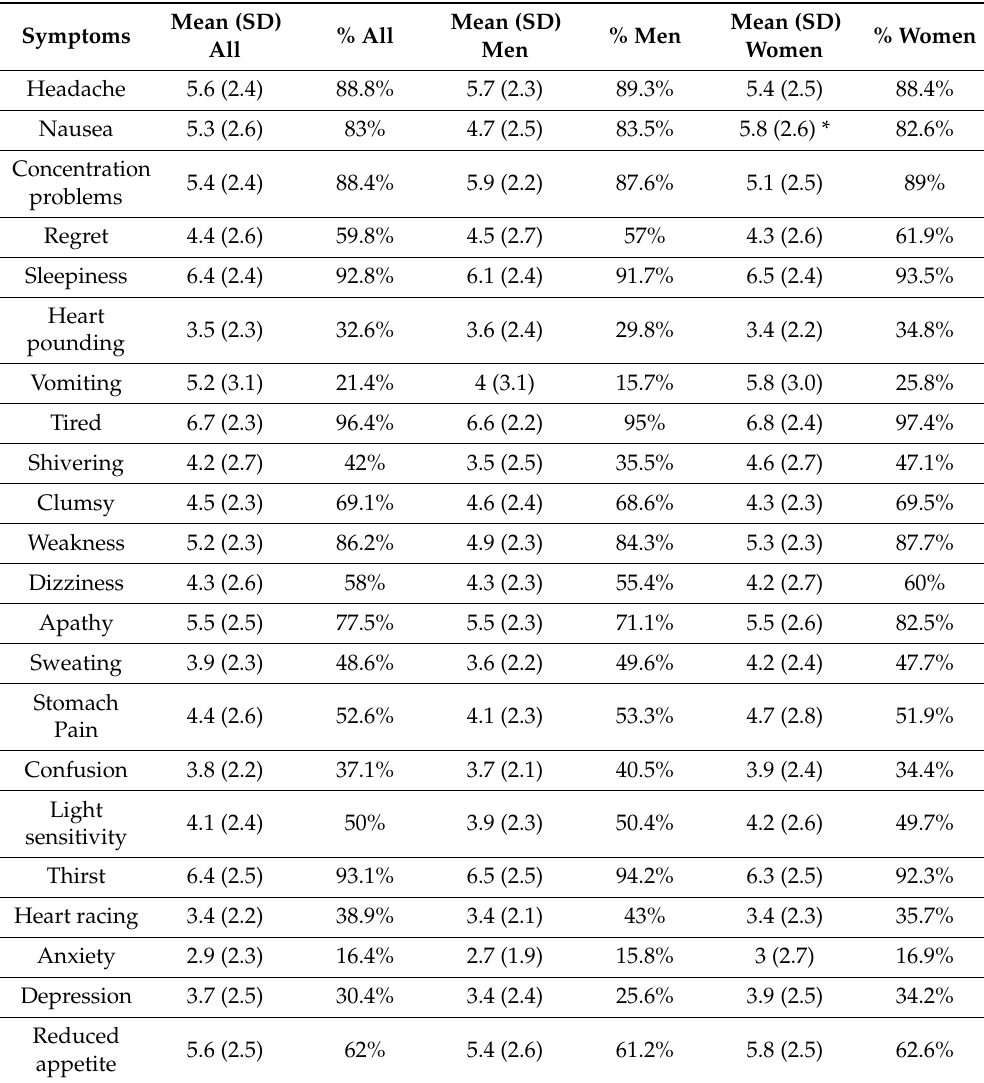
Table 4. Presence and severity of individual hangover symptoms after alcohol consumption and reaching an eBAC of 0.08% ≤ eBAC <